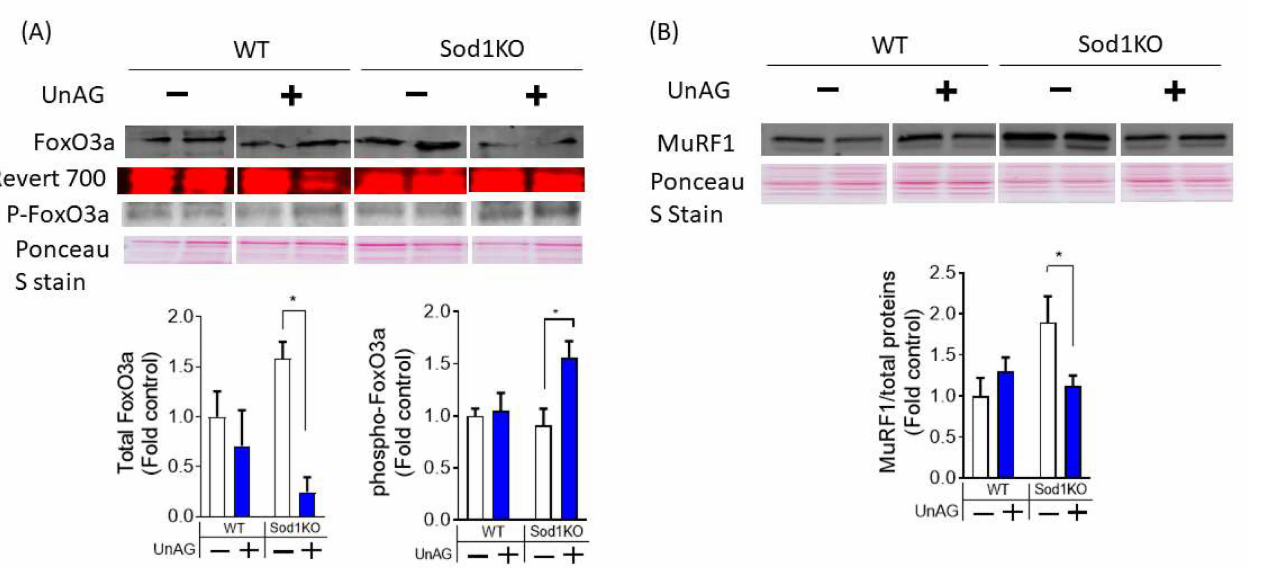
Figure 6. Unacylated ghrelin’s downstream effects in a redox dependent sarcopenia. ( A ) FoxO3a protein expression is decreased in by unacylated ghrelin in Sod1KO muscle. Phosphorylation of FoxO3a at Ser 253 was upregulated by unacylated ghrelin treatment in Sod1KO. ( B ) E3 ligase MuRF1 expression is increased in Sod1KO but downregulated by unacylated ghrelin. Two-Way ANOVAs were used to test statistical significance between groups, followed by Tukey post hoc tests. Data are mean ± SEM. * p < 0.05. Abbreviations: UnAG, unacylated ghrelin; FoxO3a, Forkhead box